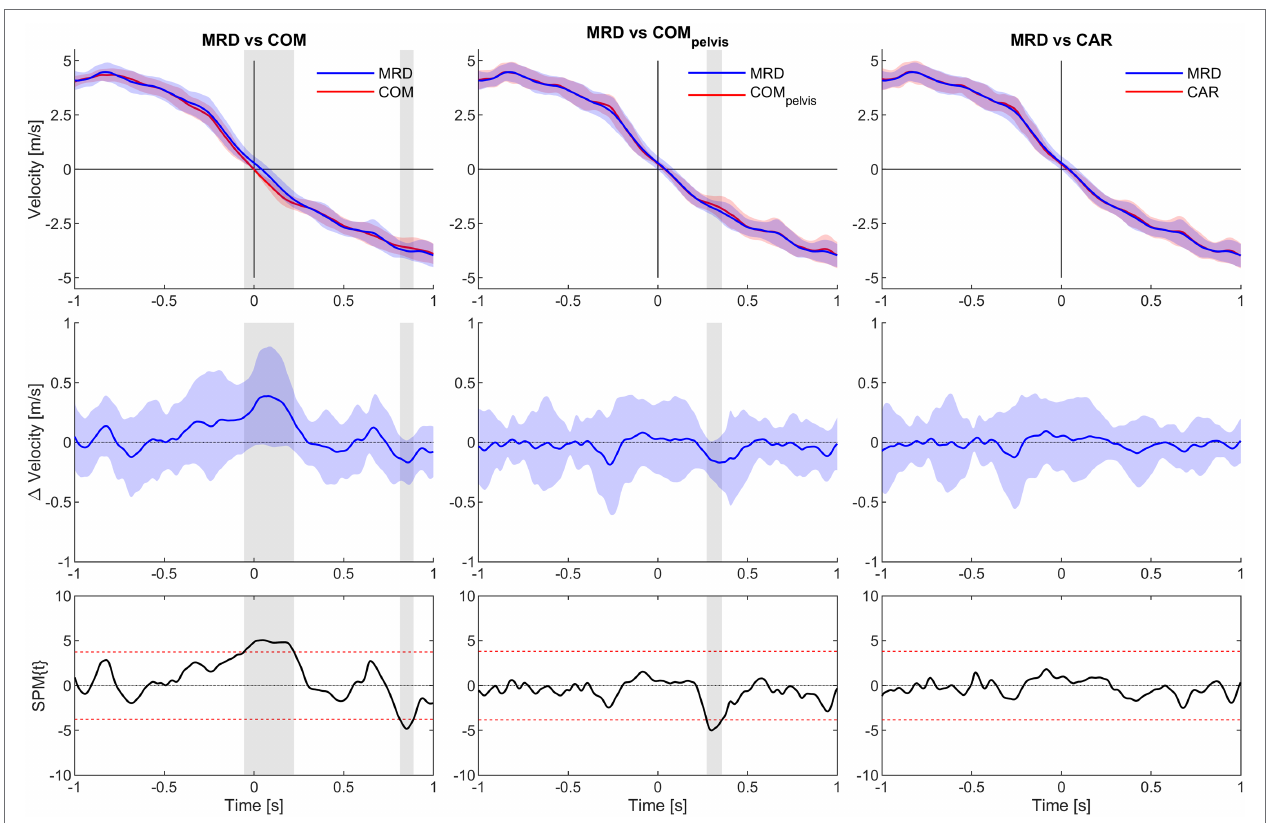
FIGURE 6 | SPM analysis of average velocity for 1.0 s time interval before ( − ) and after (+) CoD (horizontal axis all graphs) for the 6 kg condition. Columns left to right show MRD to COM, MRD to COM pelvis and MRD to CAR comparisons. Top row show average velocity of all trials with 95% confidence interval for the MRD (blue) to COM, COM pelvis and CAR (red) comparisons. Middle row show difference in velocity with 95% confidence interval. Bottom row show SPM analysis with 95% confidence interval marked with red dashed lines. Grey vertical line identify time interval of significant difference ( α <